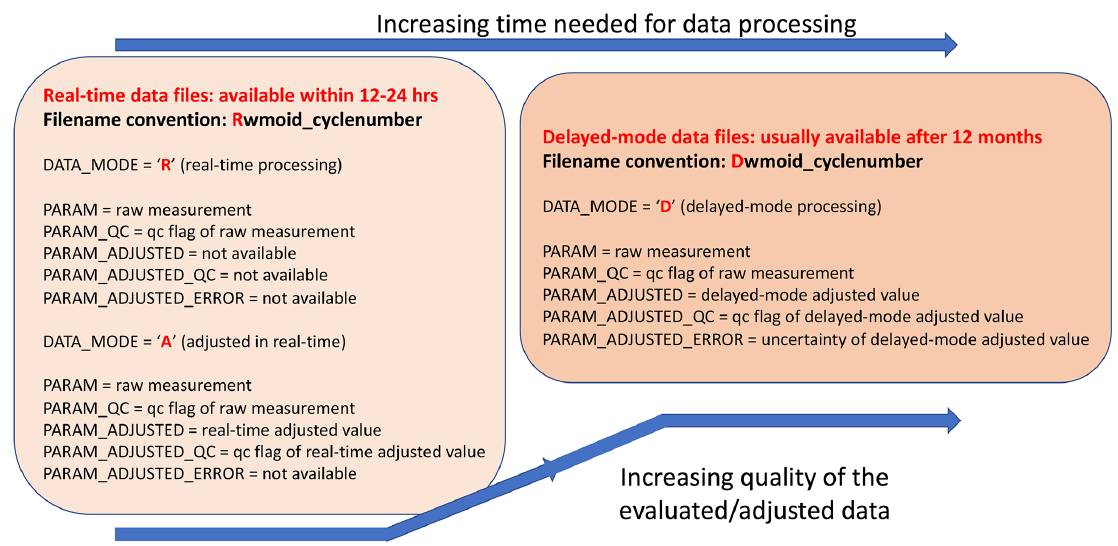
Figure 4. The variables in an Argo data file and their different timeline of availability. Data from CTDs are stored with PARAM = PRES, TEMP, PSAL. For biogeochemical data, please refer to Bittig et al. (2019). The highest quality Argo data are those stored in PARAM_ADJUSTED, with PARAM_ADJUSTED_QC = “1” and DATA_MODE = “D”